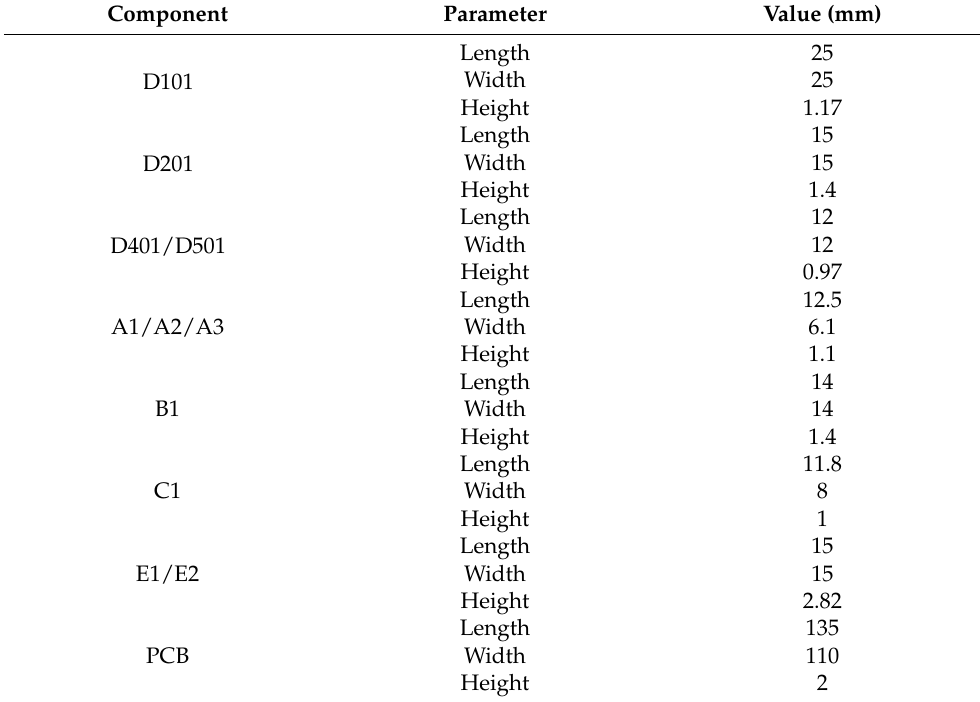
Figure 6. The finite element model of the key device: ( a ) D201, ( b ) D501. Table 3. Packaging structure parameters in FEA.